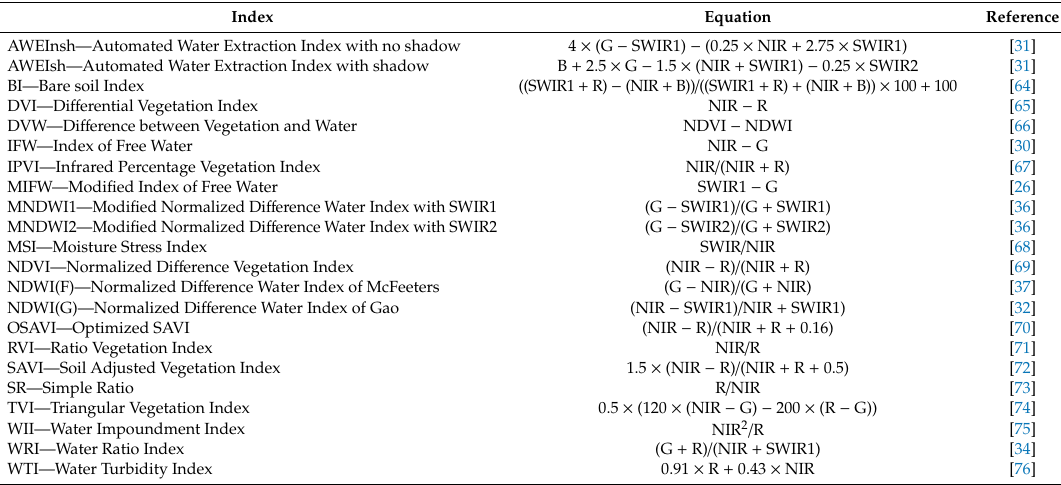
Table 2. Indices used as potential model variable in dichotomous partitioning for classifying water presence in